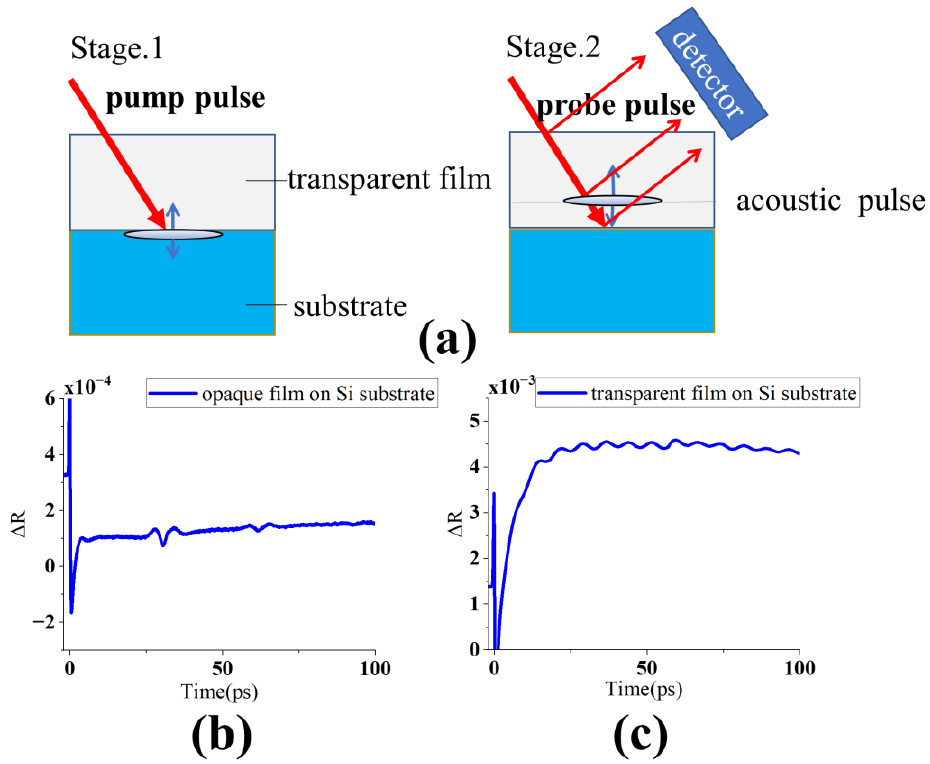
Figure 1. Sequence of events in opaque film.